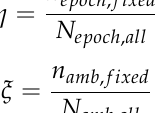
Figure 9. Distribution of European reference stations.